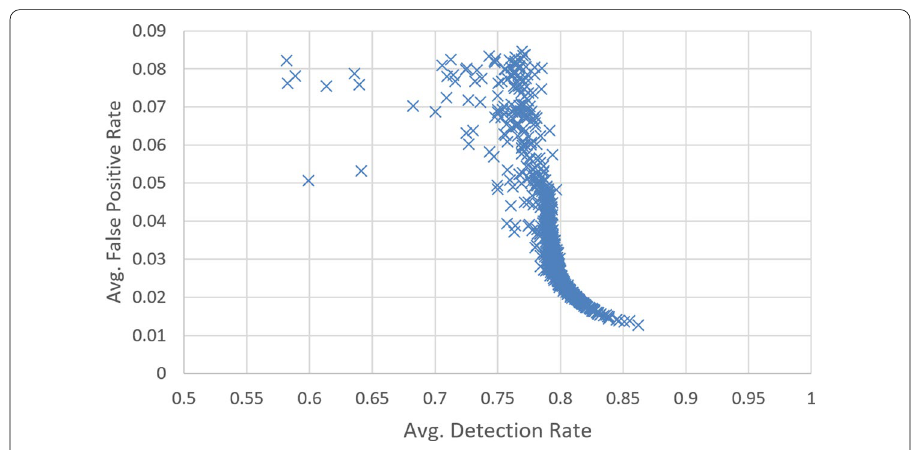
Fig. 7 Training performance of the proposed approach for